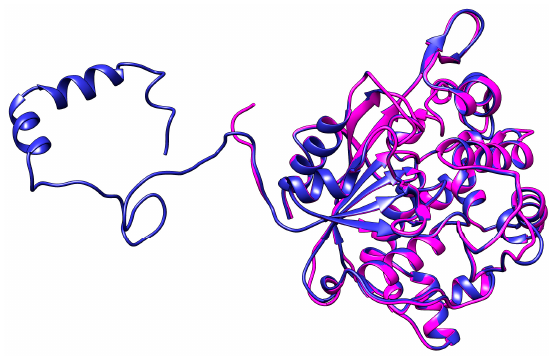
Figure 4. Superimposition of AMS3 lipase (native) and truncated AMS3 lipase. Blue represents the native and magenta the truncated AMS3 lipase. The RMSD value for lipase domain was 0.35 Å.